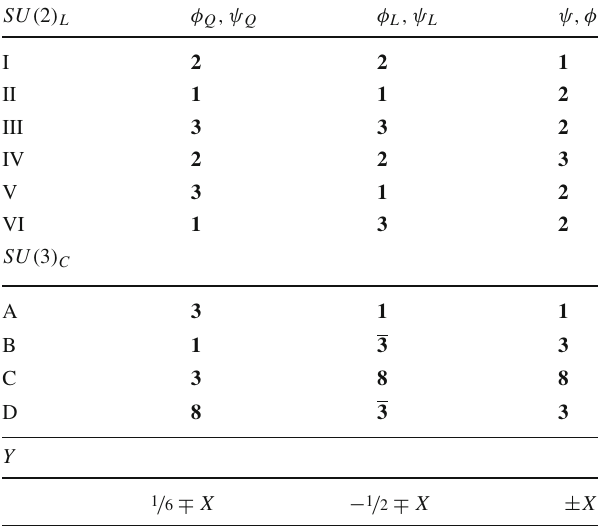
Table 1 All possible choices for the combinations of representation of the new particles such that they allow for an one-loop contribution to b → s μ + μ − . The upper sign of ± belongs to a-type models, the lower to b-type